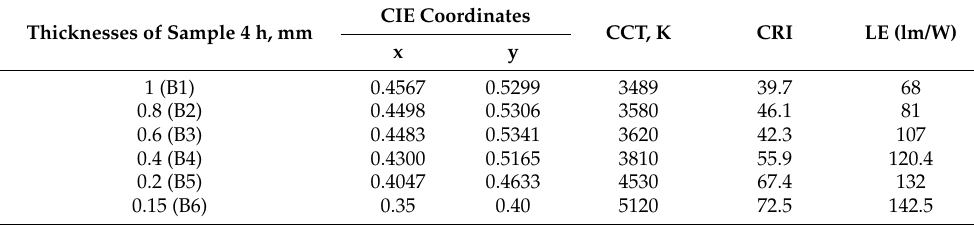
Table 3. CIE chromaticity coordinates, CTT and luminous efficiency of a WLED lamp fabricated on the base of 450 nm LED chip and (Al 2 O 3 -YAG): Ce eutectic (sample 4) with different thicknesses. CIE Thicknesses of Sample 4 h, mm